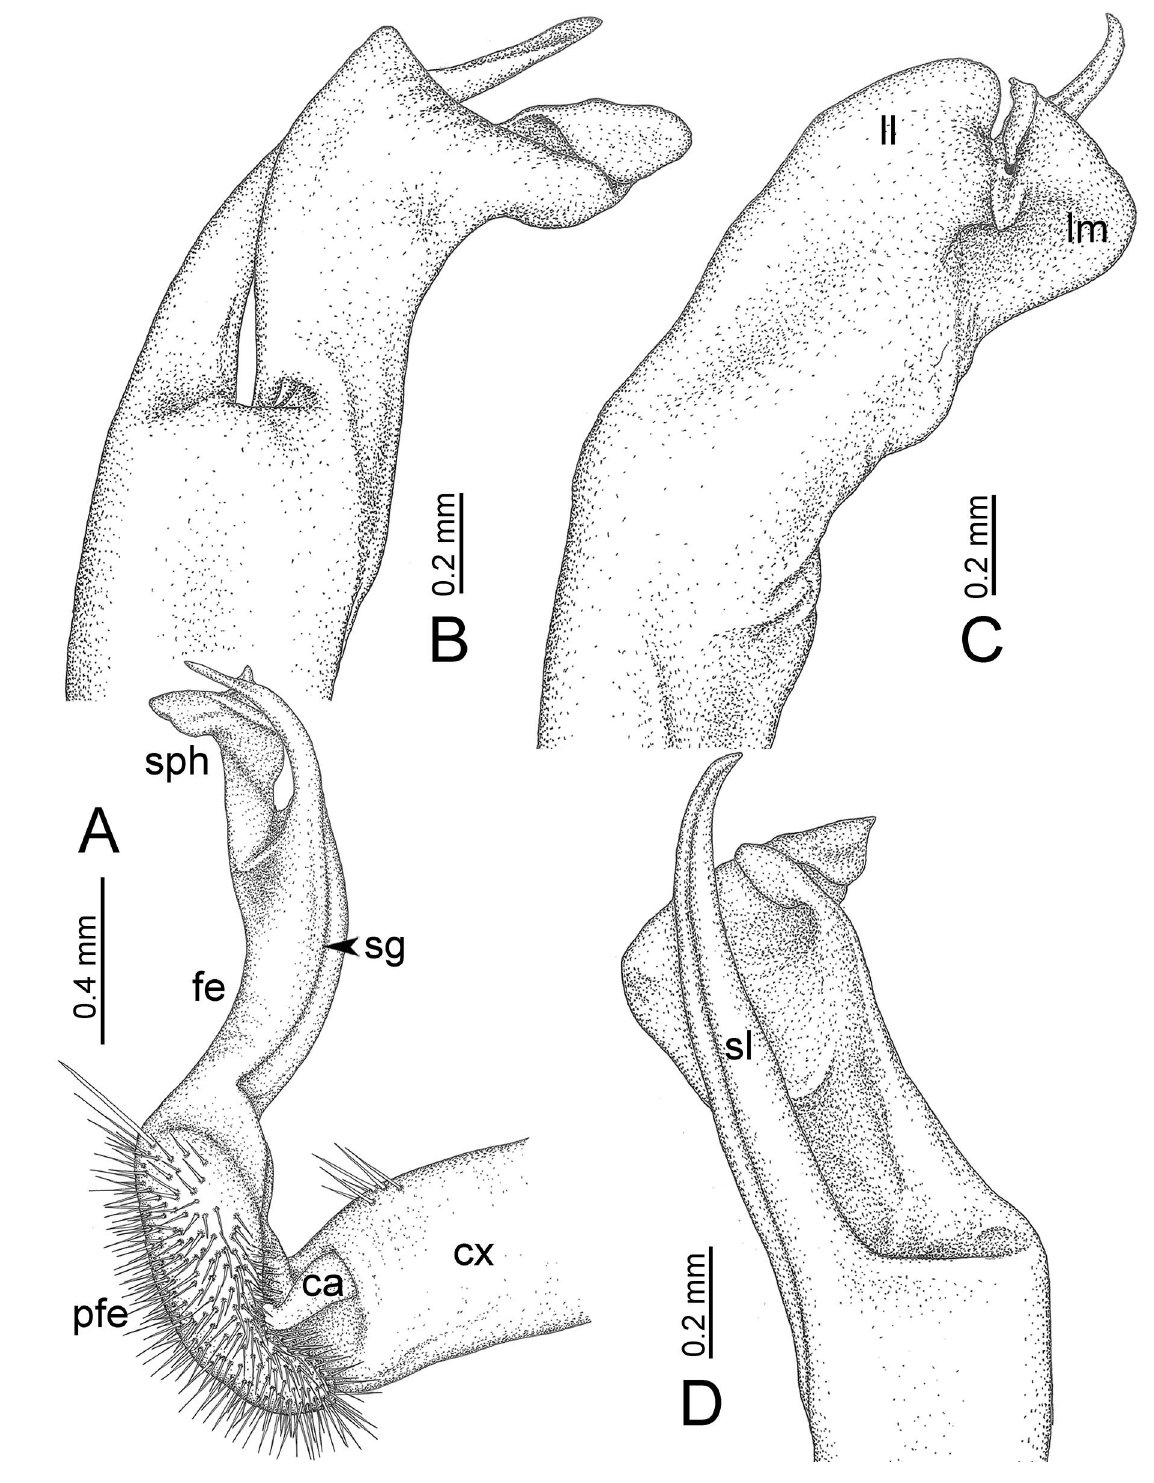
Fig. 17. Gigaxytes parvoterga Srisonchai, Enghoff & Panha gen. et sp. nov . , ♂ paratype – right gonopod. A . Mesal view. B . Lateral view. C . Ventral view. D . Dorsal